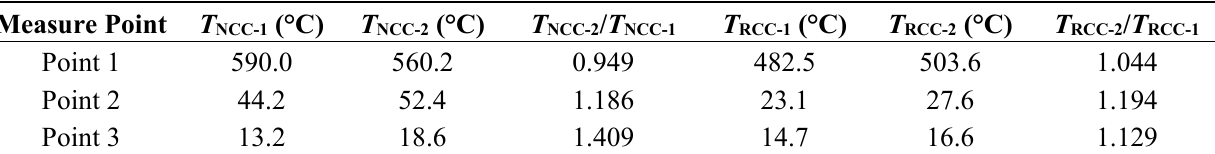
Table 5. The temperature and corresponding ratio at measure points in the 39-min heating. Measure